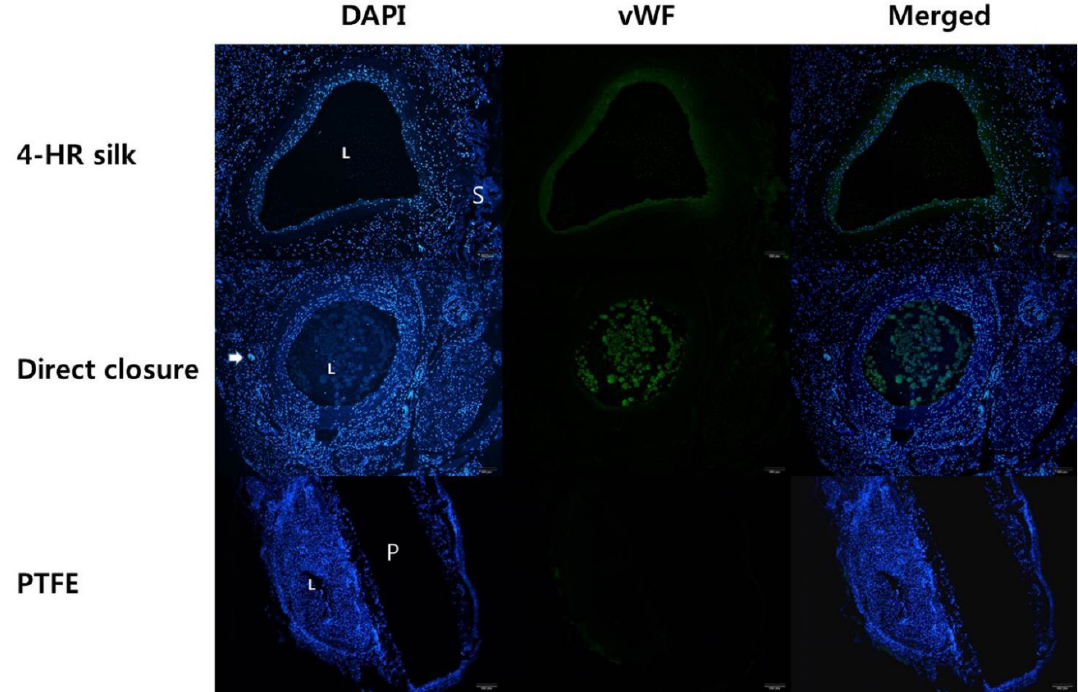
Figure 8. Fluorescence examination results for von Willebrand factor (vWF) expression (L: lumen, S: silk patch; original magnification ×100, scale bar = 100 μm).